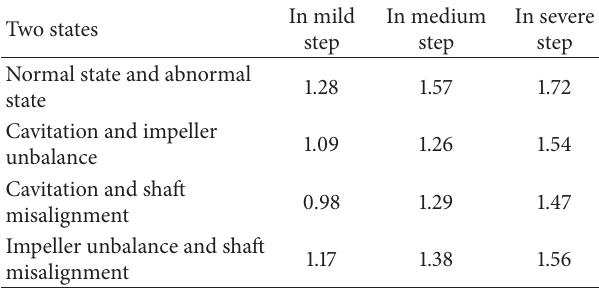
Table 4: DI values of new SSPs in the same abnormal degree from the estimated